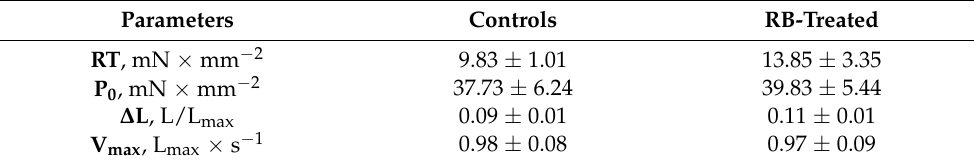
Table 3. Isometric and isotonic contraction parameters in control and RB-treated rats.